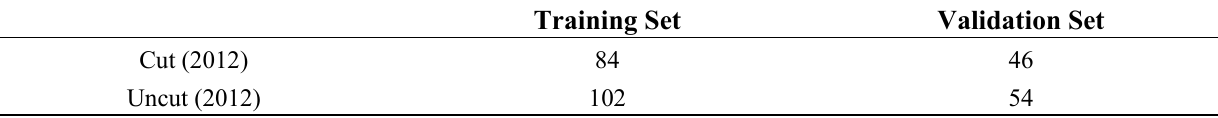
Table 1. Final proportion of treatments in training and validation data